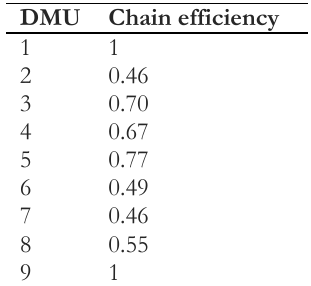
Table 7. Calculation of supply chain system efficiency score with CCR.